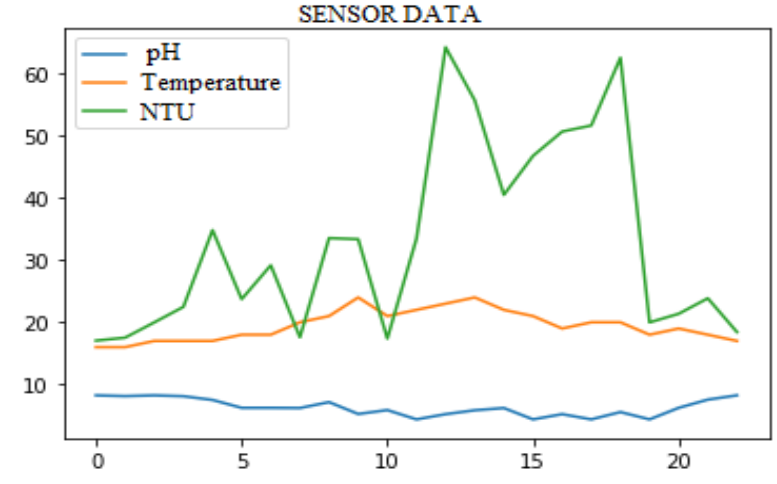
Figure 12. Sensor-generated data acquired per hour during a